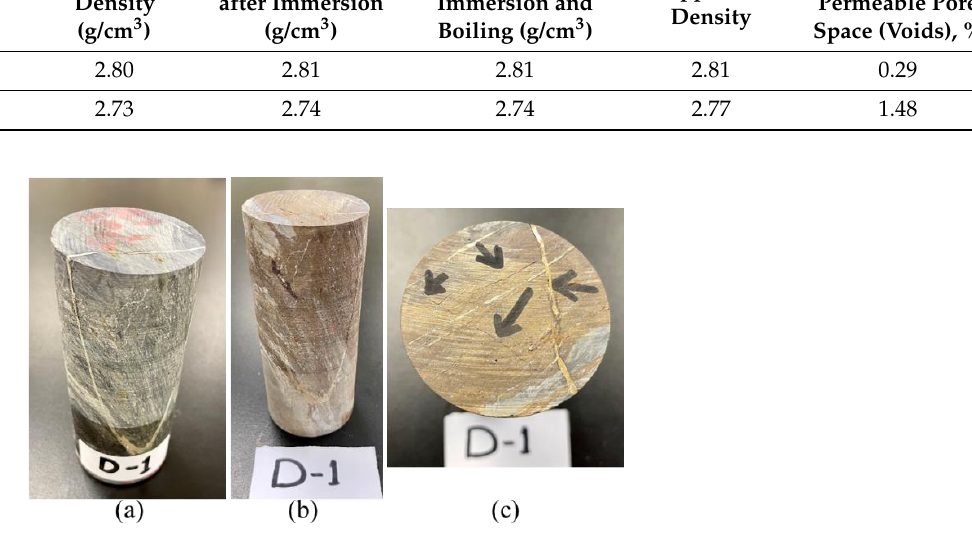
Figure 13. ( a ) A specimen at room temp, ( b ) A specimen after heating to 600 °C, and ( c ) visible cracks after heating to 600 °C.